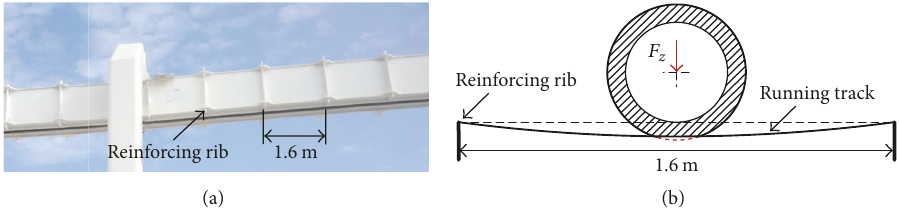
Figure 5: The monorail track: (a) the reinforcing rib and (b) the compressed deformation of